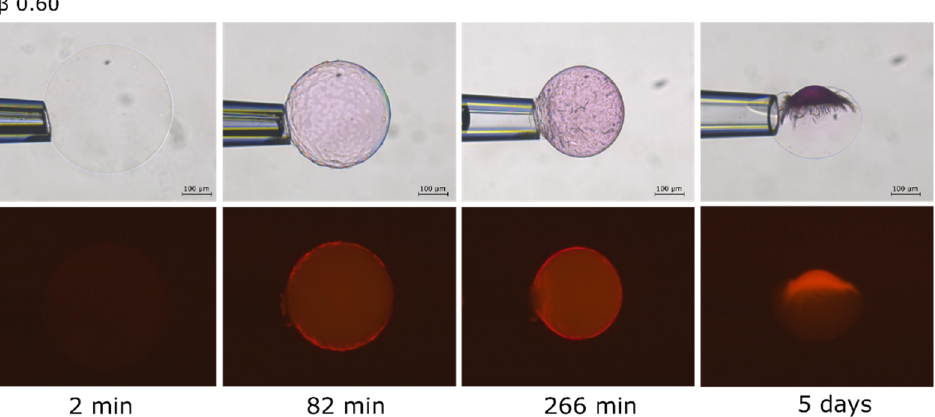
Figure 5. AMT distribution in a polyacrylate microgel at β = 0.6. Images of the microgel taken at different times to show the redistribution of the AMT inside the gel.